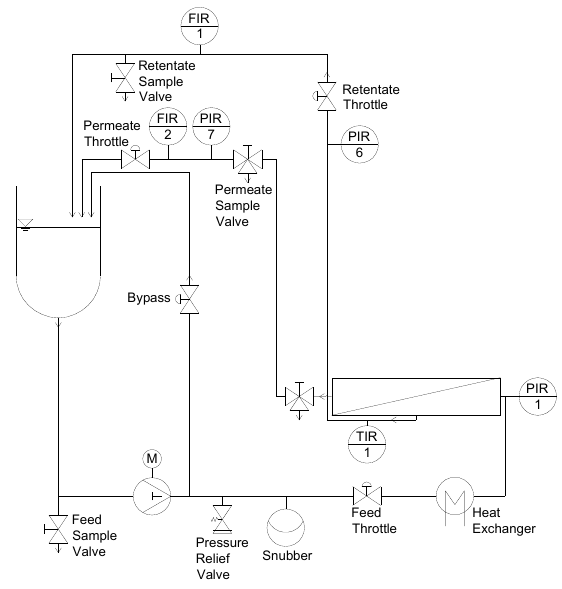
Figure 1. Test cell filtration plant (adapted from [9]).